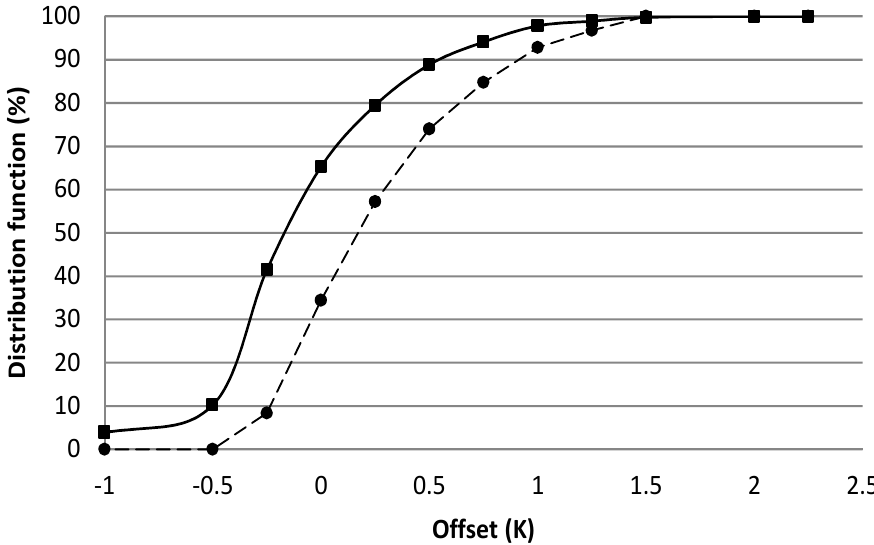
Figure 7. Probability distribution function for the offset in July (circle) and August (square).